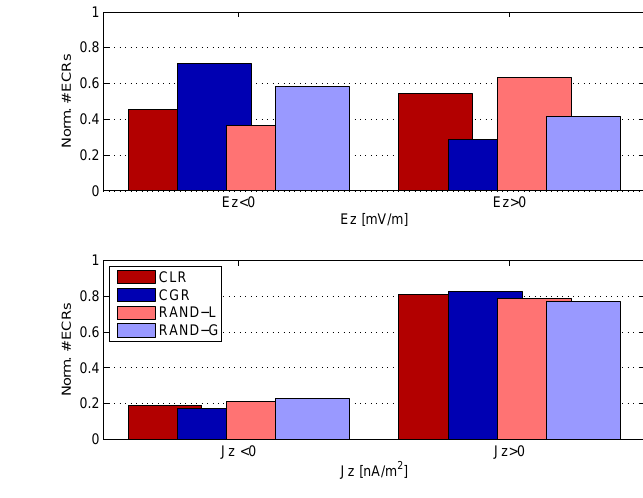
Fig. 9. Histograms of the DSI y electric field and current density. For loads (CLRs and RAND-Ls), we see the expected dominance of E y > 0 and J y > 0, while the results for generators (CGRs and RAND-Gs) are less clear.